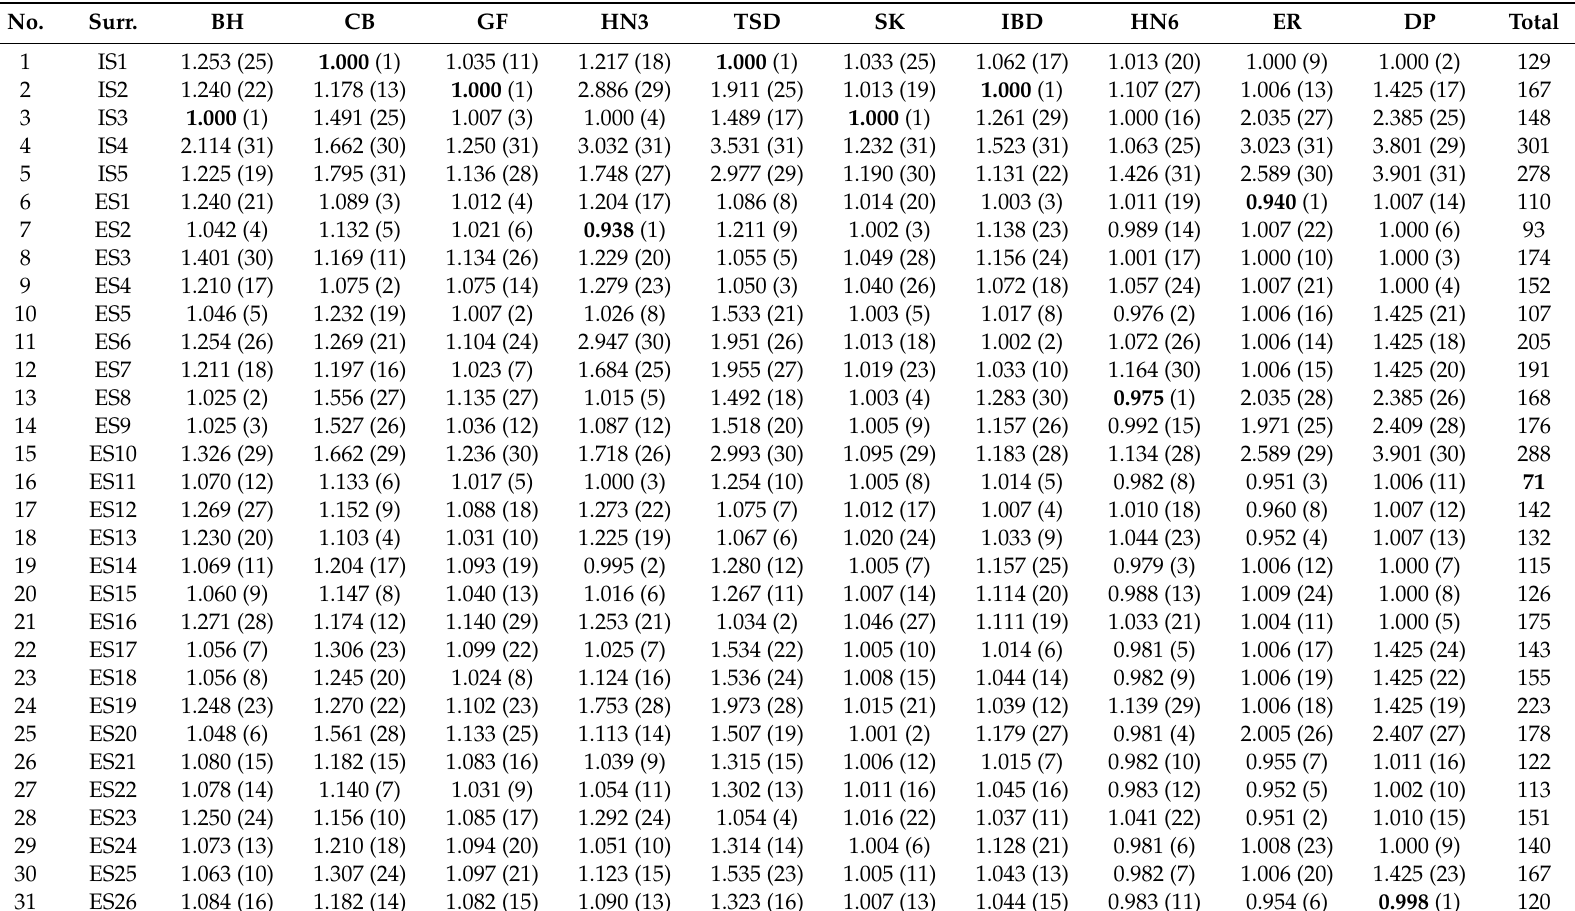
Table 5. Comparison of performance measure maximum absolute error (MAE) for all test